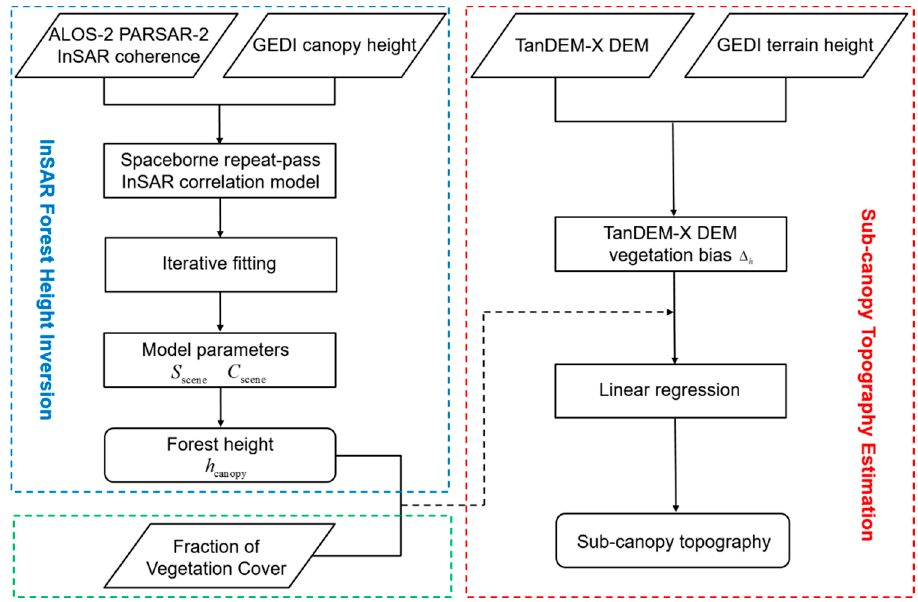
Figure 2. The workflow of the proposed method for estimating the sub-canopy topography.